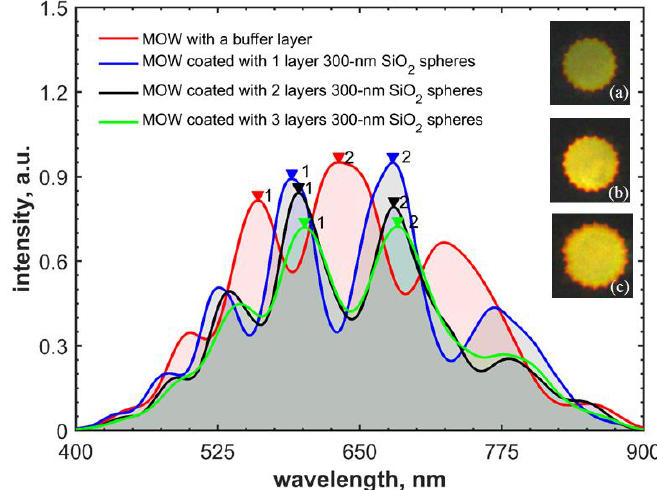
Figure 11. Transmission spectra for MOWs coated with the buffer layer only (red) and with one (blue), two (black), and three (green) layers of 300-nm SiO 2 particles. Inserts are the mode profiles of MOWs with one ( a ), two ( b ), and three ( c ) layers of 300-nm silica particles. Table 3. Shifts of the transmission peaks for MOWs driven by layers of 300-nm silica particles. Spectral Shift, nm